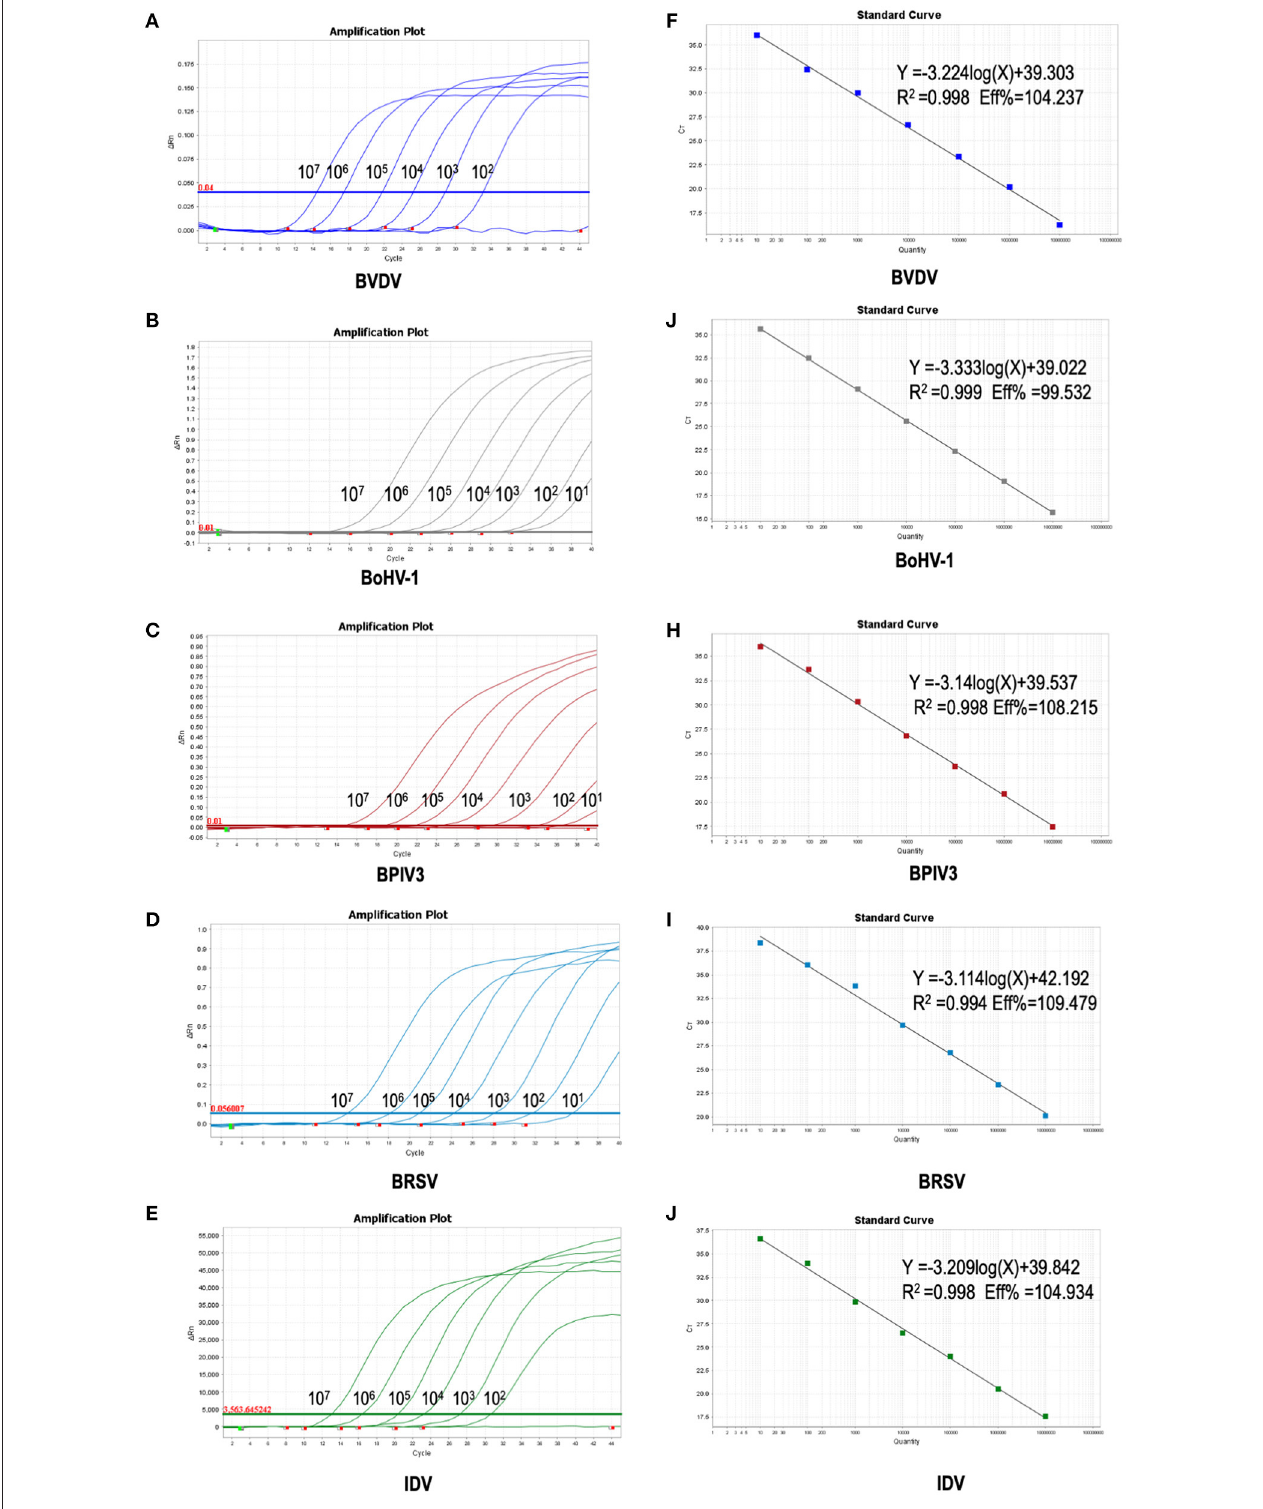
FIGURE 4 | Sensitivity of the multiplex real-time PCR assay: (A–E) amplification curves (X-axis: Cycle, Y-axis: 1 Rn) of plasmid standards of BVDV, BoHV-1,BPIV3,BRSV and IDV detected by multiplex real-time PCR. (F–J) standard curves of plasmid standards of BVDV, BoHV-1, BPIV3, BRSV and IDV. F: BVDV: Y = − 3.224log(X) + 39.303 R 2 = 0.998 Eff% = 104.237; (G) : BoHV-1: Y = − 3.333log(X) + 39.022 R 2 = 0.999 Eff% = 99.532; (H) : BPIV3: Y = − 3.14log(X) + 39.537 R 2 = 0.998 Eff% = 108.215; (I) : BRSV: Y = − 3.114log(X) + 42.192 R 2 = 0.994 Eff% = 109.479; (J) : IDV: Y = − 3.209 log(X) + 39.842 R 2 = 0.998 Eff% = 104.934.